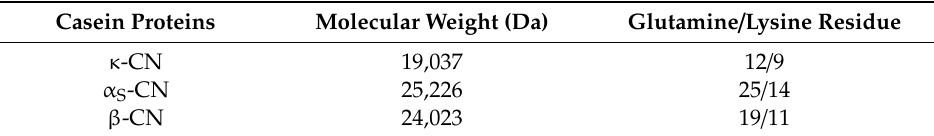
Table 1. Physicochemical features of individual caseins.